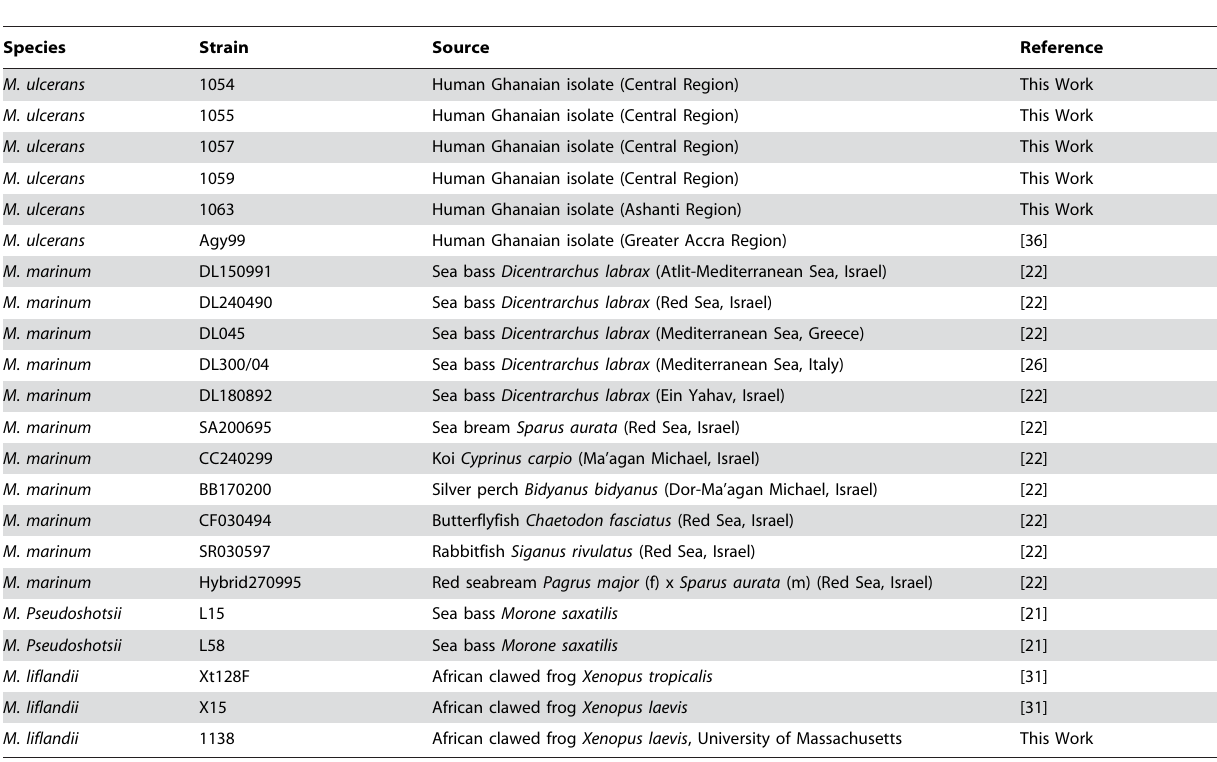
Table 1. Ghanaian isolates of M. ulcerans and other mycolactone producing mycobacteria.